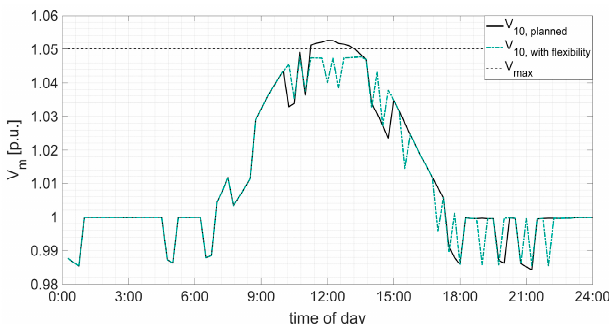
Figure 8. Comparison of voltage time series at bus ten with planned power consumption at all buses and with usage of flexibility at bus six and ten (dashed